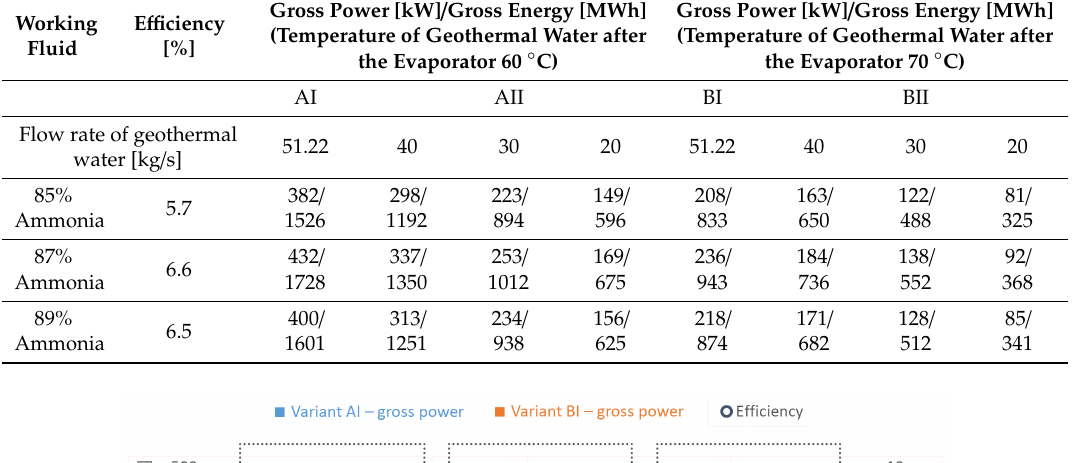
Table 3. Thermodynamic calculation for the Kalina Cycle.